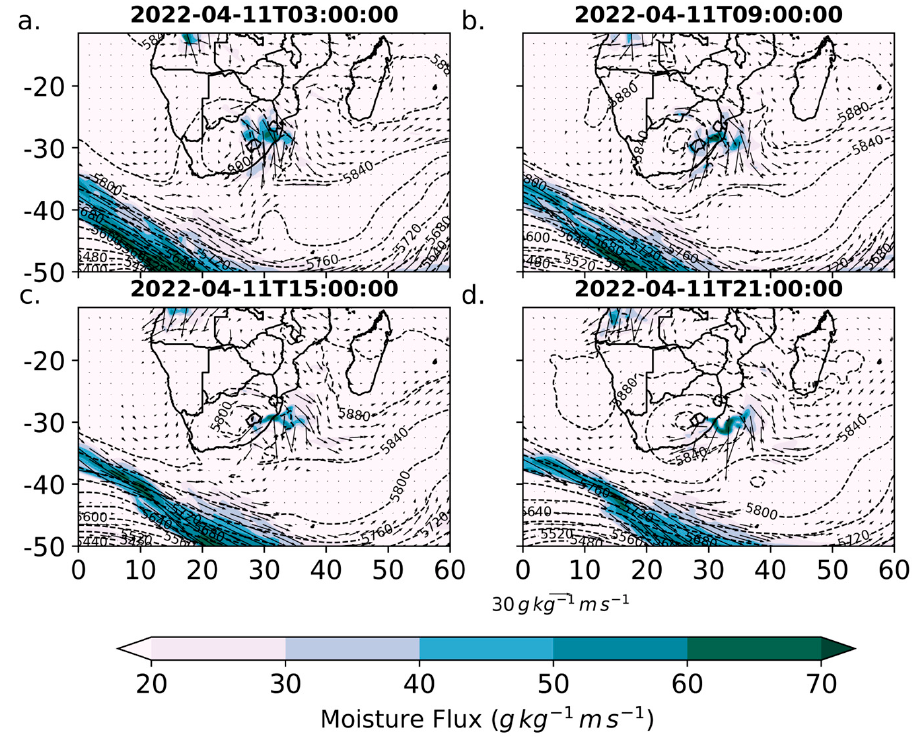
Figure 2. ERA5 geopotential height (contours; m) and moisture flux (vectors; g kg − 1 m s − 1 ) at the 500 hPa pressure level at ( a ) 0300 UTC ( b ) 0900 UTC ( c ) 1500 UTC and ( d ) 2100 UTC on 11 April 2022. Regions with moisture flux exceeding 20 g kg − 1 m s − 1 are shaded. The position of the COL can be seen in the centre of South Africa in panel ( b ).